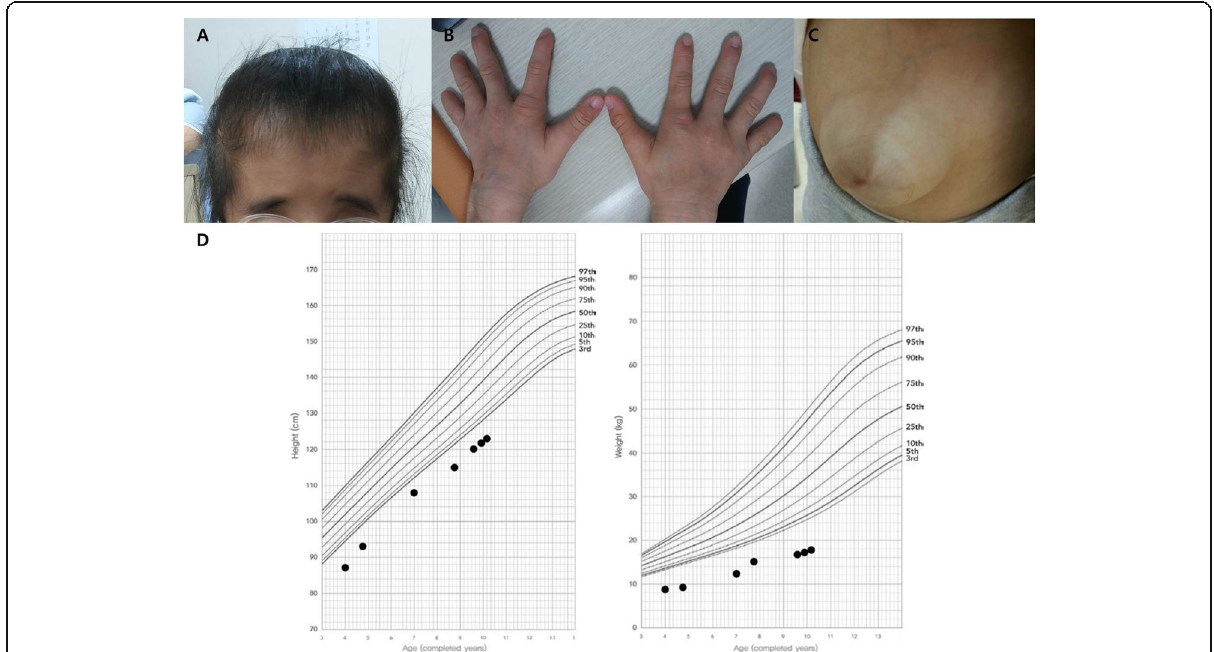
Fig. 1 Clinical features of the case reported here. a : The characteristic facial appearance included hypertrichosis, frontal bossing, and a low hairline. b : Hypoplastic distal phalanges and anonychia are noted in the left 4th and both 5th fingers. c : The patient underwent repair of a large umbilical hernia. d : The height and weight up to 10 years of age are plotted against a Korean national growth chart [13]. The square markers indicate the data pertaining to our patient